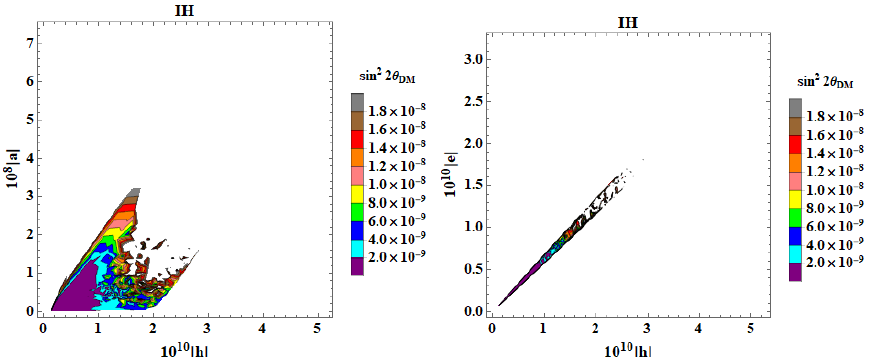
Figure 15 . Variation of di(cid:11)erent model parameters (in eV) with the DM-active mixing as the contour for inverted hierarchy. The limit as predicted by cosmology is (10 (cid:0) 12 (cid:0) 10 (cid:0) 8 ).